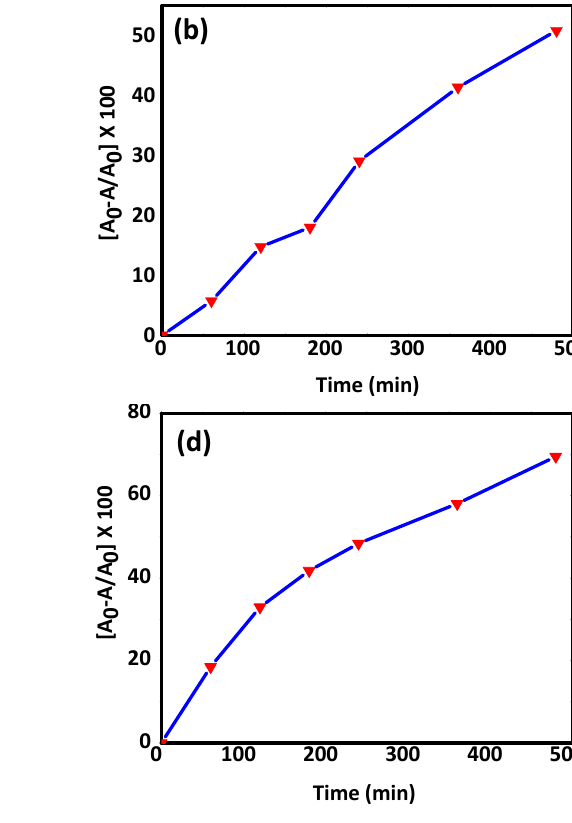
Figure 5. Self-degradation summary of RhB and NB under light; ( a , c ) variation in UV-Visible spectra/absorbance at different intervals of time; ( b , d ) represent the percentages of decomposition of dyes versus time for RhB and NB, respectively.